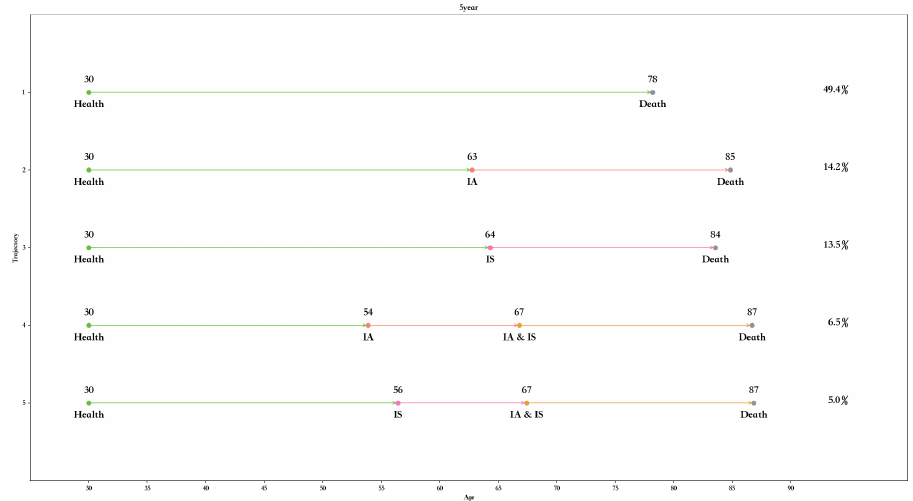
Figure 7. Disease progression trajectory of 5-year interval